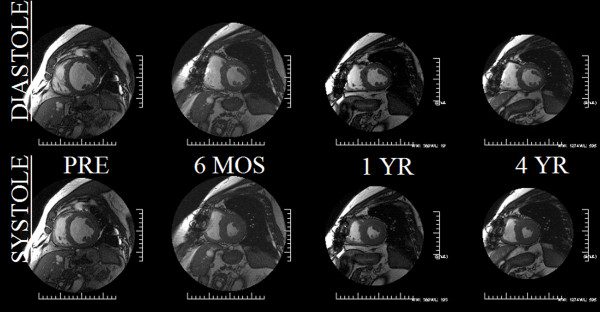
Demonstrating that, despite marked afterload mismatch in a 55YOWM with an LVEF 23% and LV mass of 251 g, surgical relief of afterload in a patient with demonstrated myocardial reserve (mean/peak gradients of 52 and 33 mmHg, respectively) can ensue with striking improvements in LVEF and LV mass (57%EF and 197 g at 6 months post-AVR) with minimal change by year 4 (LVEF 56% and LV mass 158 g). The initial improvements in morphometrics and volumetrics paralled marked improvements in the patients clinical response, again most evident within the first 6 months post-AVR.